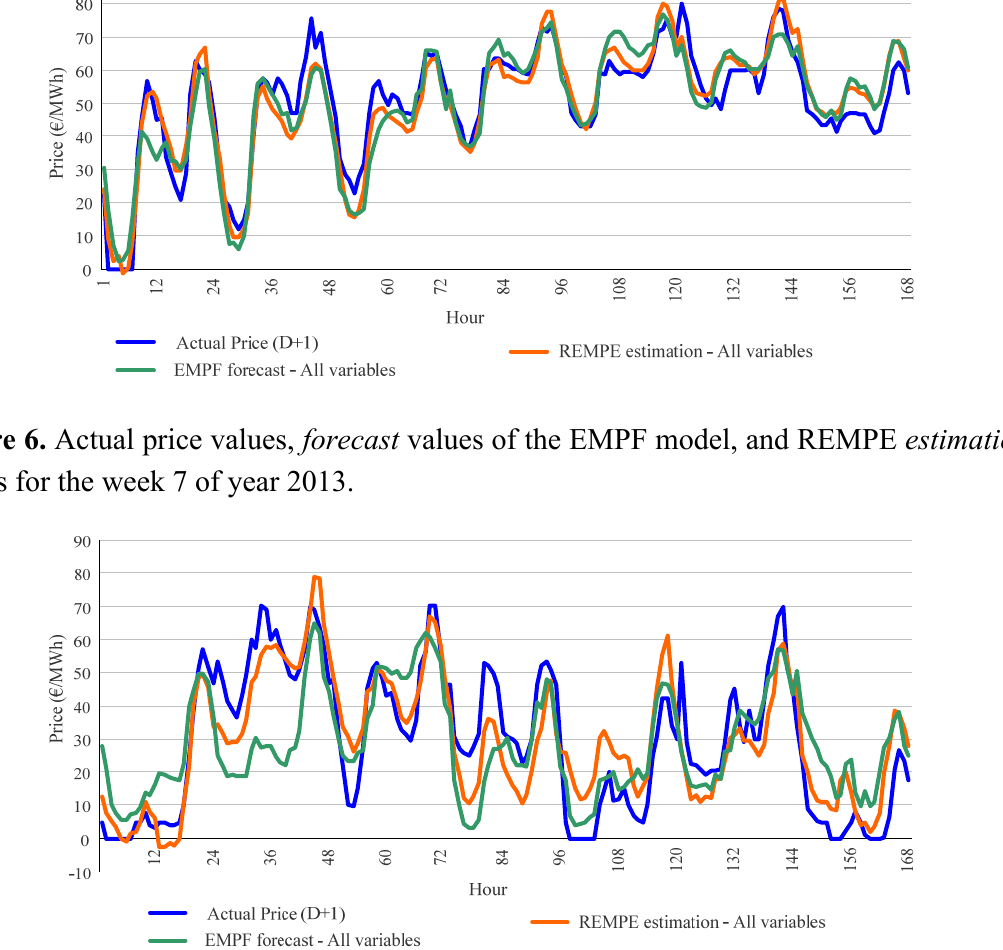
Figure 7. Actual price values, forecast values of the EMPF model and REMPE estimation values for the week 12 of year